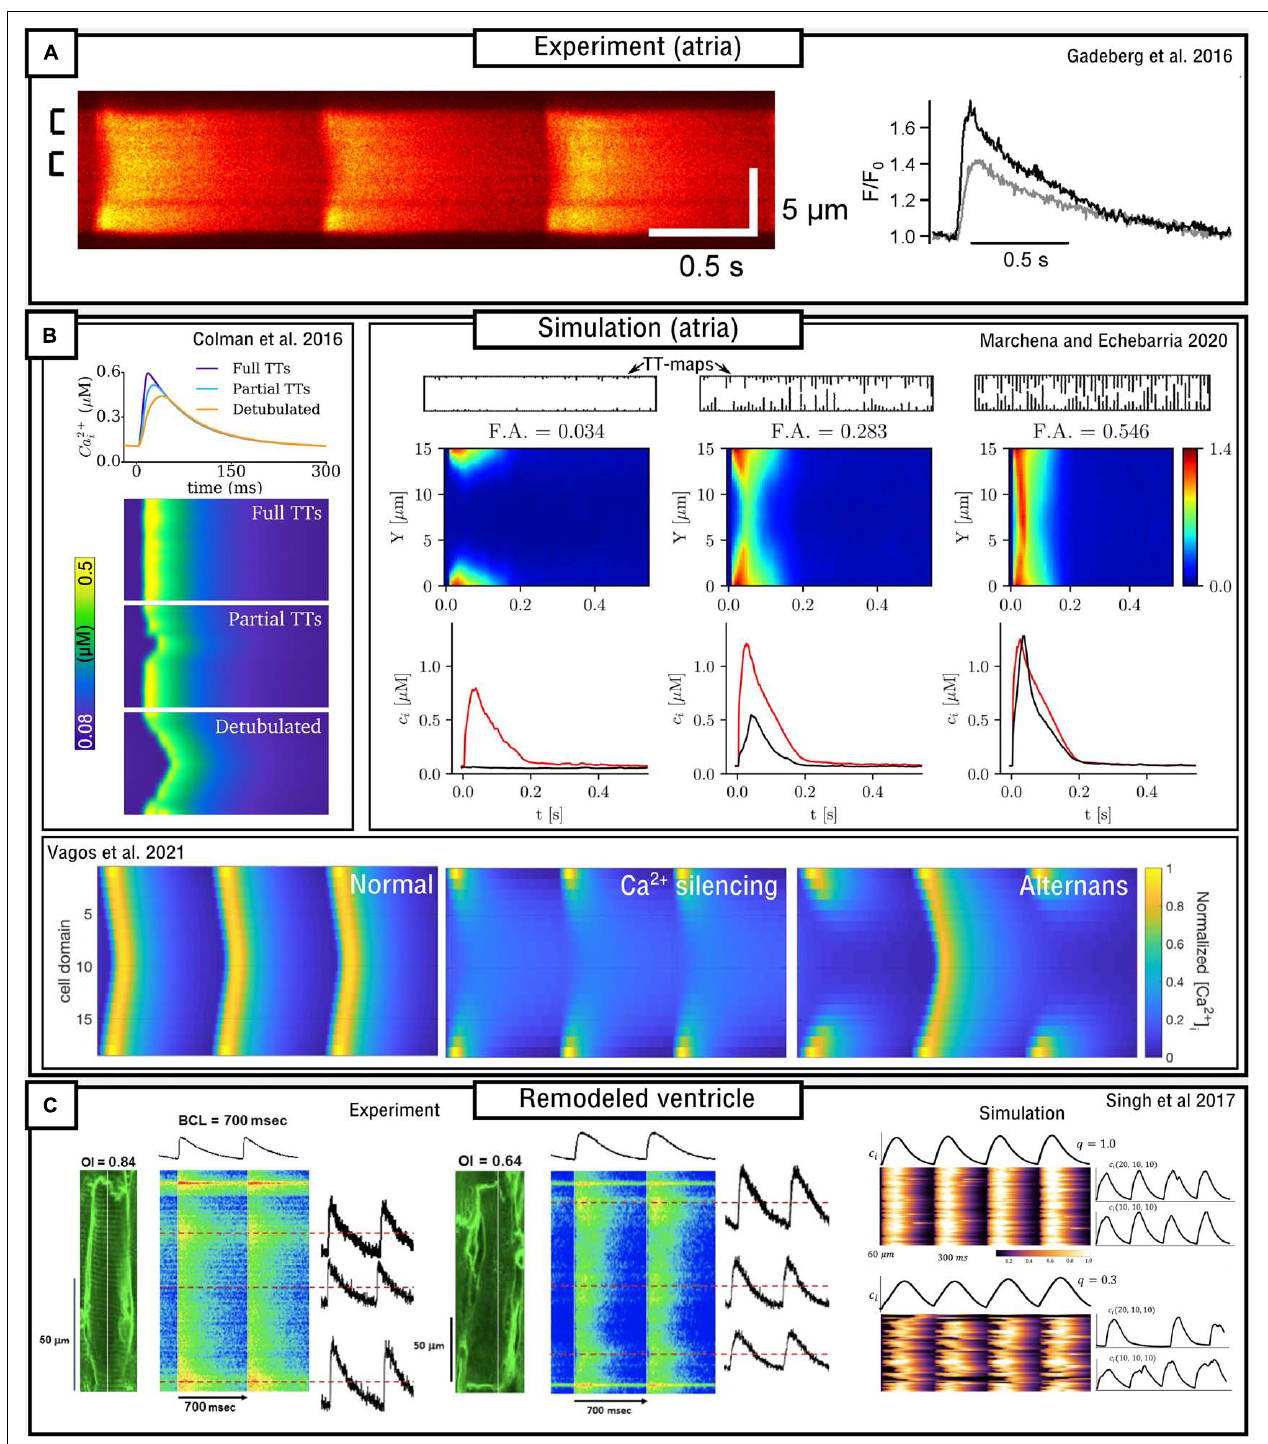
FIGURE 6 | Models of variable T-system density in atrial and remodeled ventricular myocytes. (A) Experimental data demonstrating “u” waves in pig atrial myocytes, and the corresponding local CaTs at the surface (black) and interior (gray) of the cell. Data is from Gadeberg et al. (2016). (B) Dynamics in different computational models of atrial cells, illustrating recapitulation of “u” waves, dependence on T-system density, and Ca 2 + silencing and CaT alternans. Data from Colman et al. (2016); Marchena and Echebarria (2020), and Vagos et al. (2021). (C) Experimental and simulation data from remodeled ventricular myocytes (Singh et al., 2017), demonstrating a loss of T-system density and associated loss of spatial synchrony of the CaT, in relation to the Organizational index (OI; experiment) and the proportion of CRUs associated with LTCCs (q; simulation).